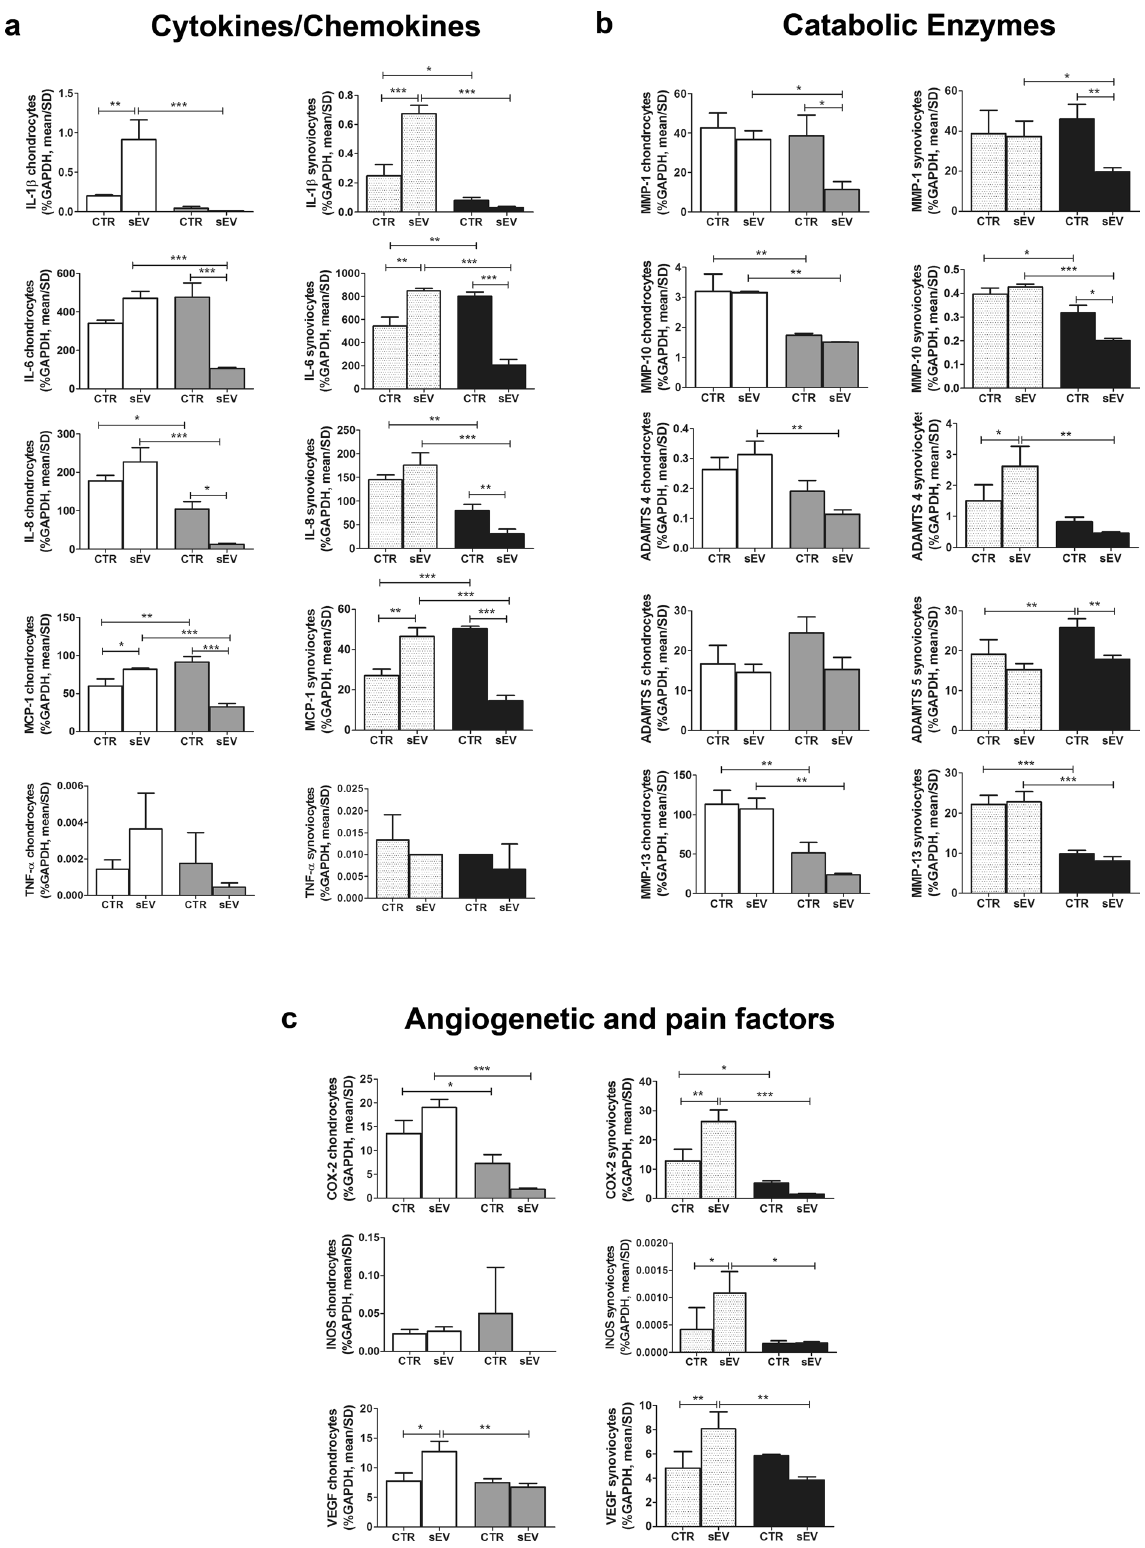
Figure 3. sEV effects on gene expression of Cytokines/Chemokines ( a ), Catabolic Enzymes ( b ) and Angiogenetic and Pain Factors ( c ). Data were normalized to GAPDH. Each graph reports data collected from 3 independent sEV samples and expressed as means ± SD. Data were compared by ANOVA, followed by Tukey’s post hoc test, with * p < 0.05, ** p < 0.01, *** p < 0.001. Left graphs are related to chondrocytes while right graphs are related to synoviocytes. Different patterns are used for different cells and time points: chondrocytes at 4 h: white; chondrocytes at 15 h: gray; synoviocytes at 4 h: finely dotted; synoviocytes at 15 h: